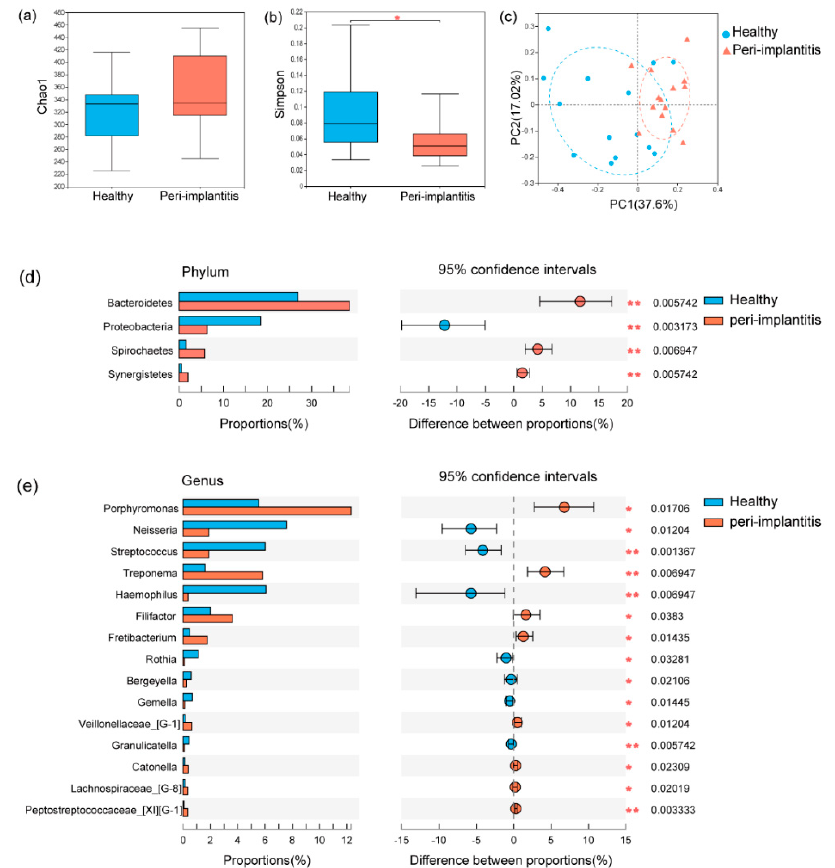
Figure 1. Microbial profile of healthy implants and peri − implantitis. The microbial richness pre- sented with Chao1 ( a ) and microbial diversity presented with Simpson ( b ) were analyzed with a Wilcoxon signed − rank paired test. ( c ) Principal coordinate analysis (PCoA) based on Unifrac distance measurements showed the difference between healthy implants and peri − implantitis ( p = 0.002, R = 0.26). The microbial composition of healthy implants and peri − implantitis was explored in terms of the relative abundances at the phylum level ( d ) and genus level ( e ) using the Wilcoxon signed − rank paired test. * p < 0.05, ** p <